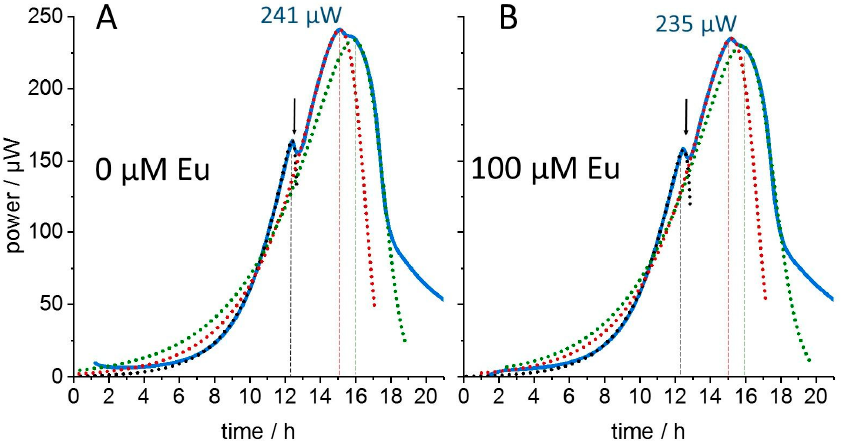
Figure 1. Thermograms of L. lactis cultures in the absence ( A ) and presence ( B ) of 100 µM 153 Eu. Simulated thermograms (dotted lines) were fitted according to Equations (1) and (2) using the analysis method dAR-TS [13]. Details are described in the text. The metabolic activity exhibited an initial fast exponential phase (black dotted line) followed by two consecutive metabolic states with slower growth (red and green dotted lines) evident from their extrapolated initial exponential growth phases (ca. first 10 h). The simulated curves cover both rising and falling metabolic activities. The presence of the stable 153 Eu had little effect on the thermogram shapes and intensities (dashed vertical lines mark the maximal thermal power for each metabolic phase in the absence of Eu). Arrows indicate small visible differences in time and magnitude of the maximal metabolic activity reached by the first metabolic phase. The root mean square deviation (rmsd) of the data from the three fitted data ranges is less than 1% of the peak maximum in each of the respective metabolic phases.